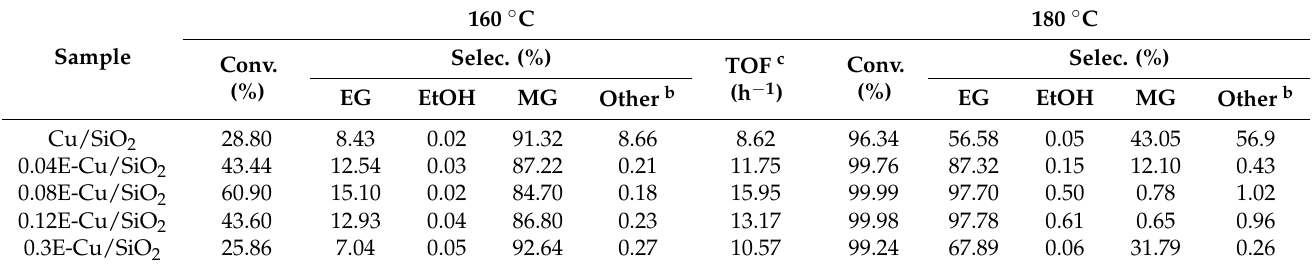
Table 3. The catalytic activity of xE-Cu/SiO 2 catalysts for DMO hydrogenation a . 160 ◦ Sample